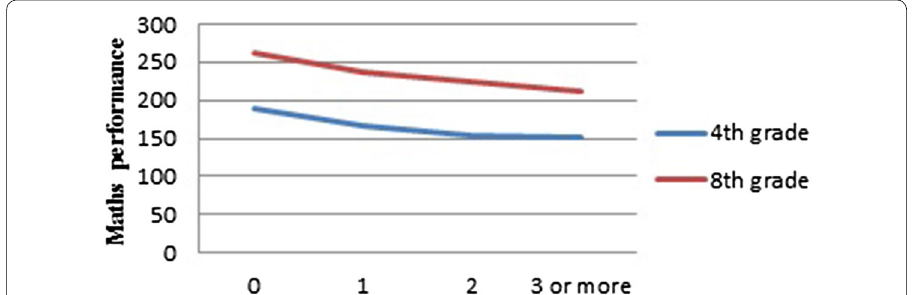
Fig. 1 Relationship betwwen student’s performance in Maths and number of years late at school Source : adapted by the authors from the estimates presented by Klein (2006; Table